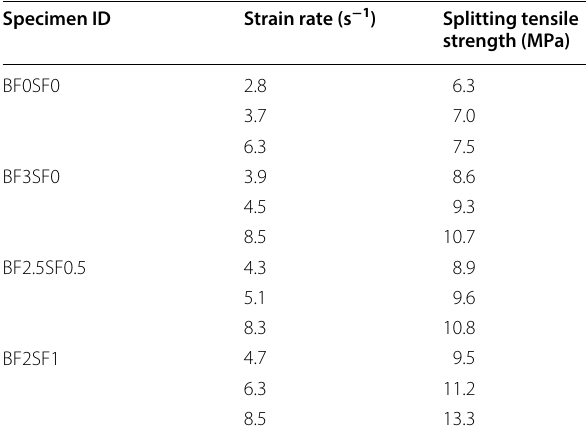
Table 6 Results of dynamic splitting tests.